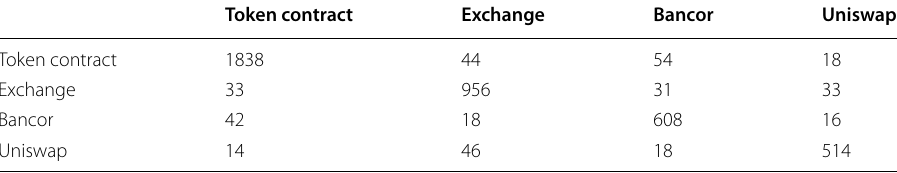
Table 16 Confusion matrix of our classification algorithm with our version of the Eros distance Token contract